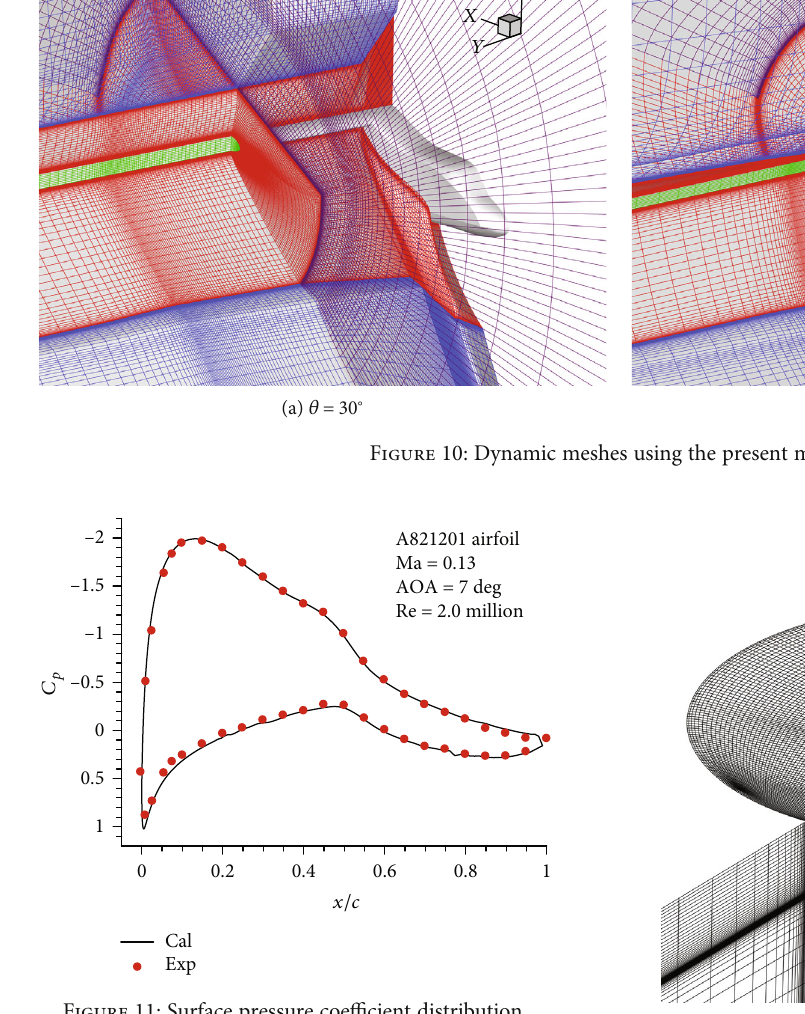
Figure 12: ROBIN airframe with actuator disk